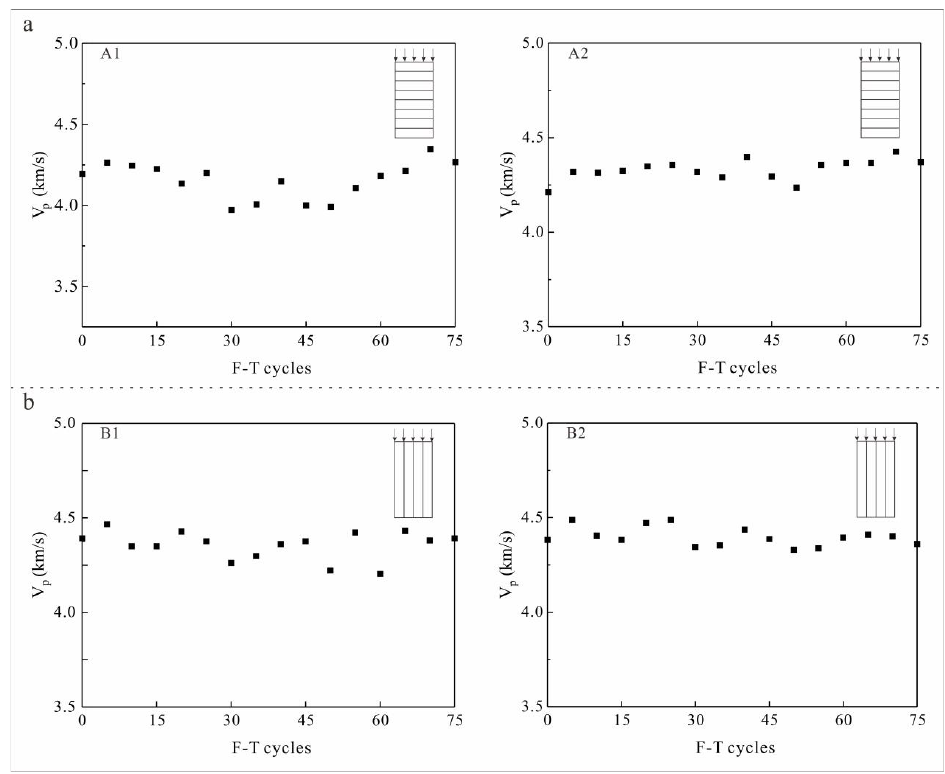
Figure 6. Wave velocity changes with F-T cycles in sandstone samples. Wave velocities propagating ( a ) perpendicular (S per ) and ( b ) parallel (S par ) to the bedding plane.